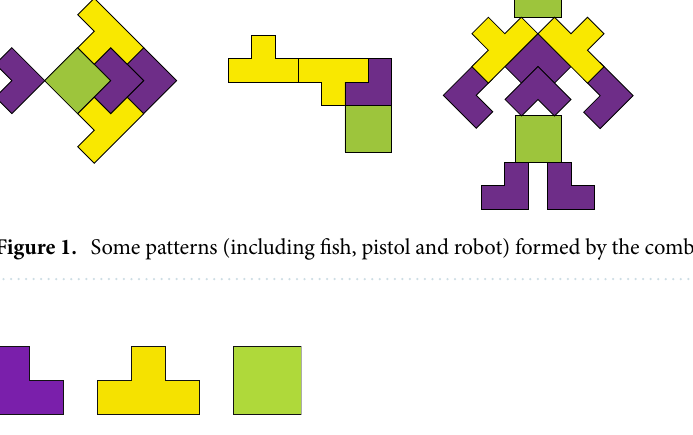
Figure 2. Some basic shapes can be arranged and combined into